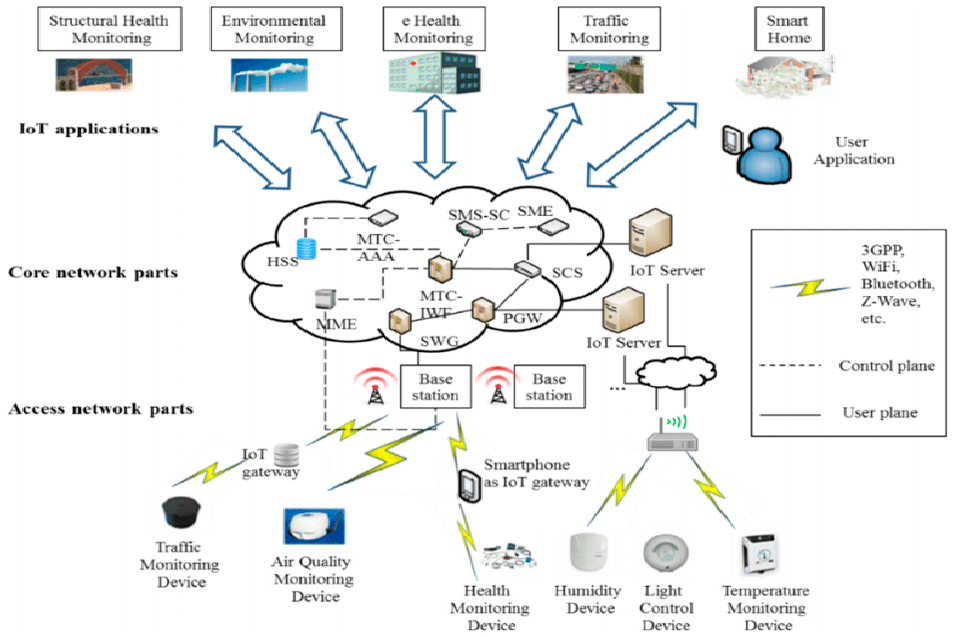
Figure 1. The network architecture of IoT-enabled applications [27].